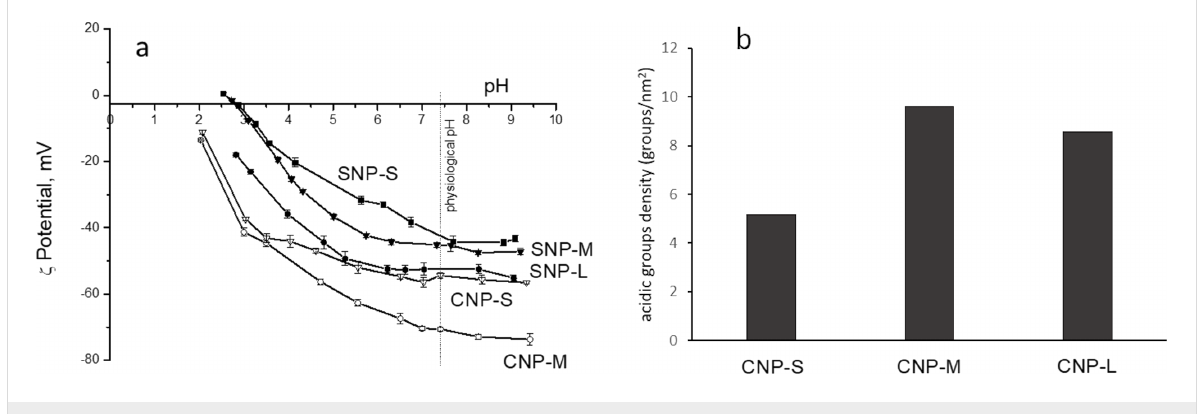
Figure 2: a) Zeta potential versus pH curves for carbon nanoparticles (CNP-M and CNP-S) and silica nanoparticles (SNP-L, SNP-M and SNP-S) suspended in water. b) Density of acid groups exposed at the surface of carbon nanoparticles.